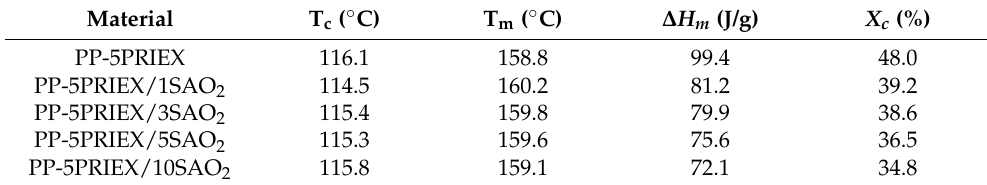
Table 2. DSC data on PP/5PRIEX / SAO 2 composites.